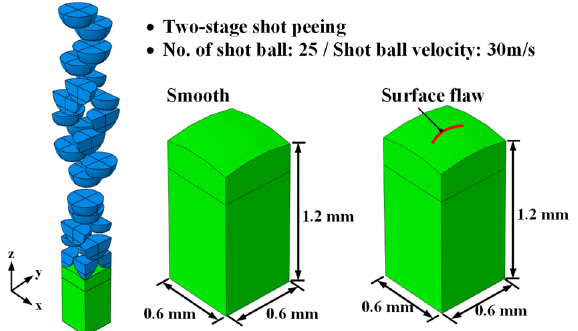
Figure 15. FE model for shot peening process.